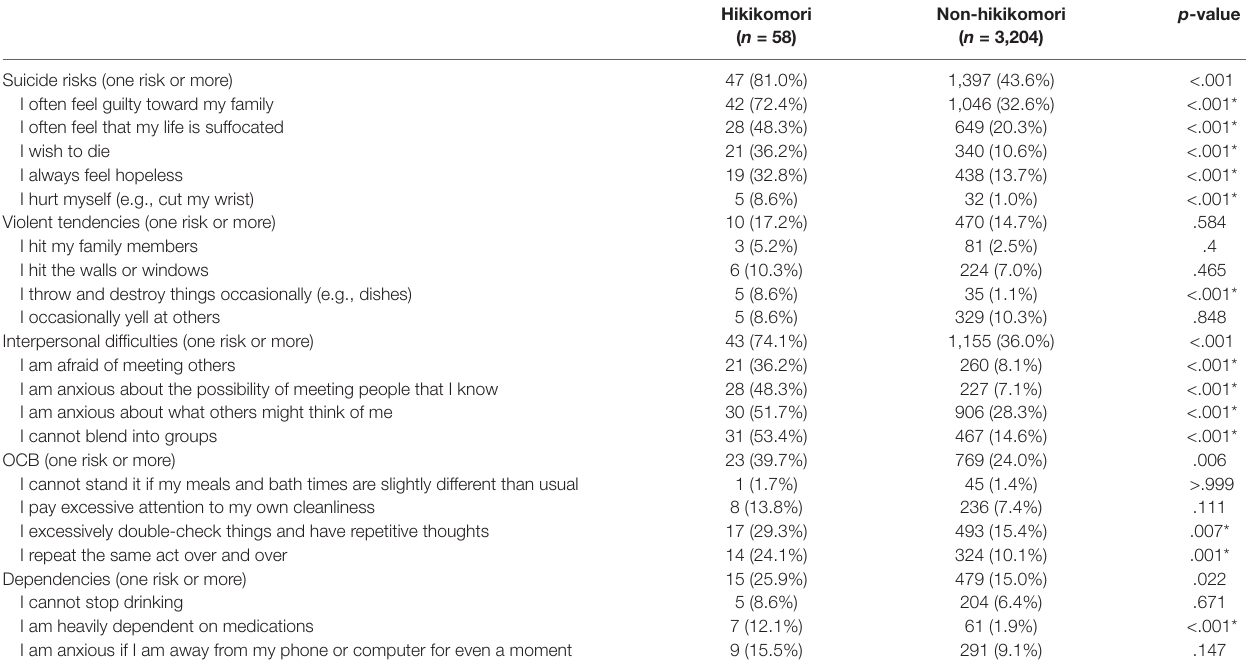
TABLE 2 | Psychiatric factors of the participants ( N = 3,262).